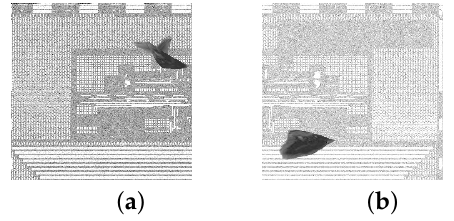
Figure 2. Data samples corrupted by Gaussian noise with two different types of intensities and simulated defects. ( a ) sample a; ( b ) sample